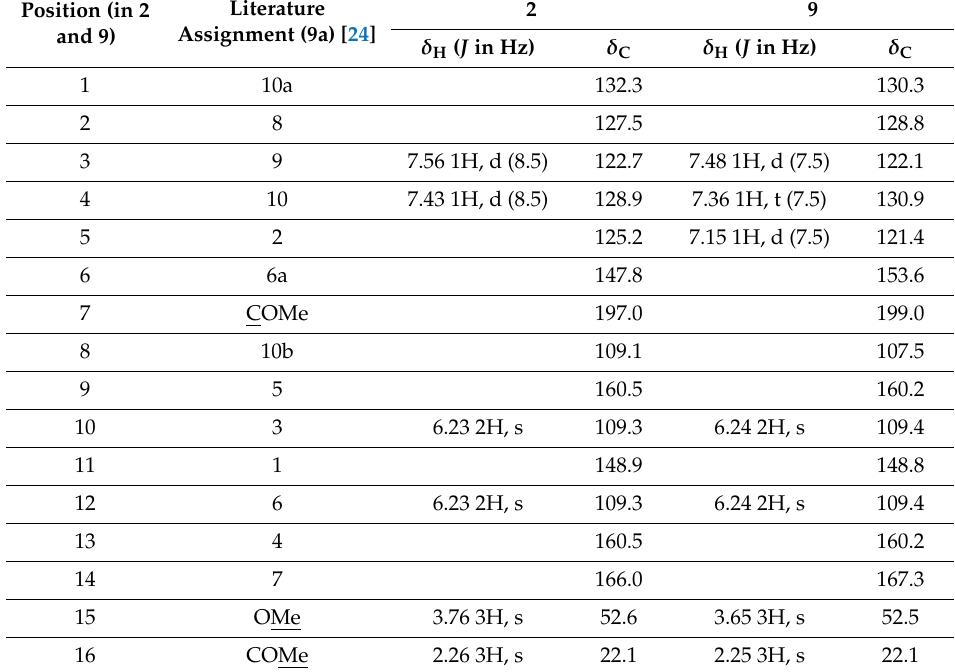
Table 2. 1 H and 13 C NMR data for benzophenones 2 and 9 (at 400 and 100 MHz respectively, in CDCl 3 , δ in